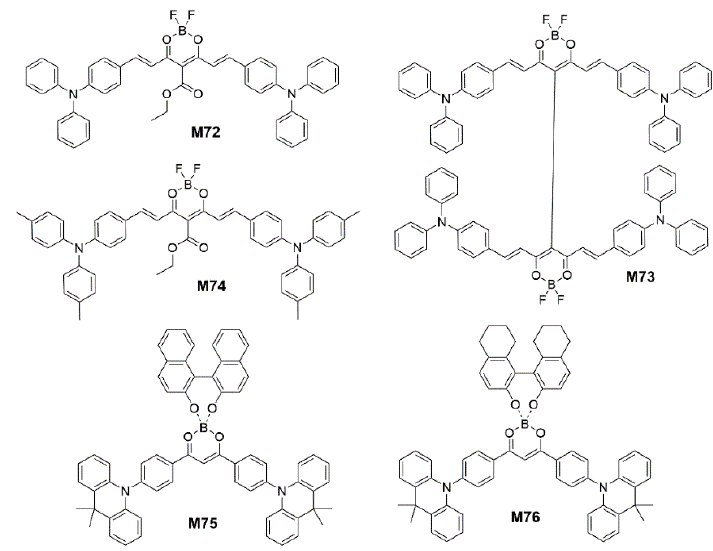
Figure 22. Chemical structures of M72 to M76 .